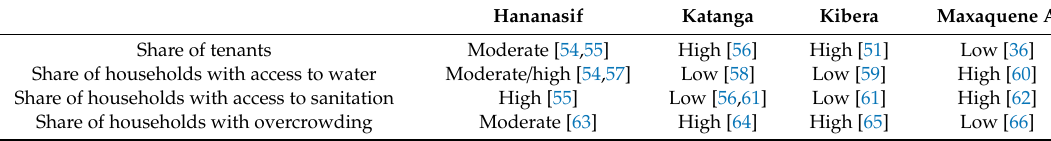
Table 3. Household conditions based on the literature